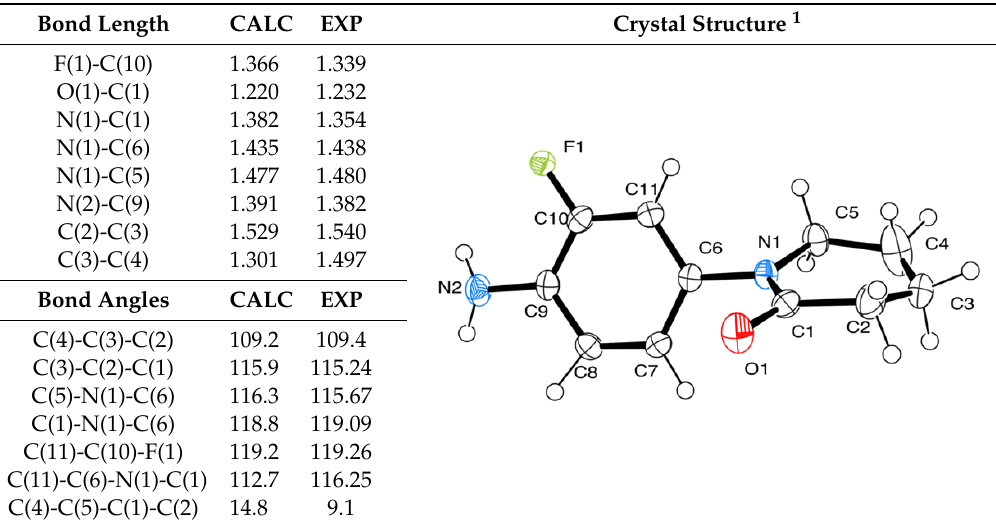
Table 5. Selected bond lengths and angles for molecule 6 .